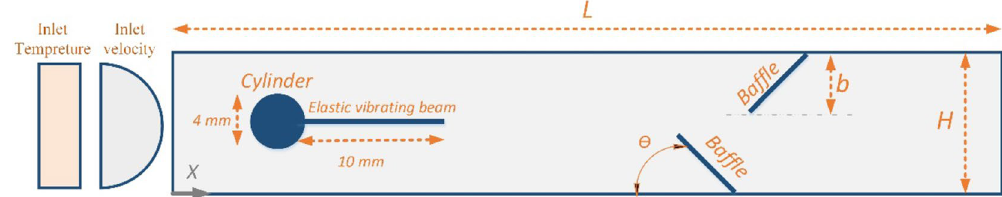
Fig. 1 Overall schema of the channel with an elastic vibrating beam and inclined